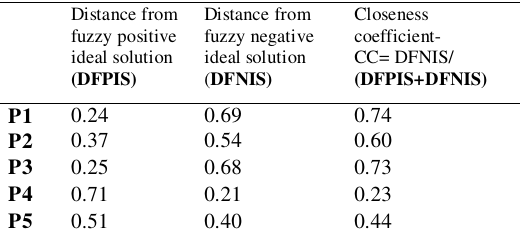
Table 9. Evaluation results via fuzzy AHP-fuzzy TOPSIS